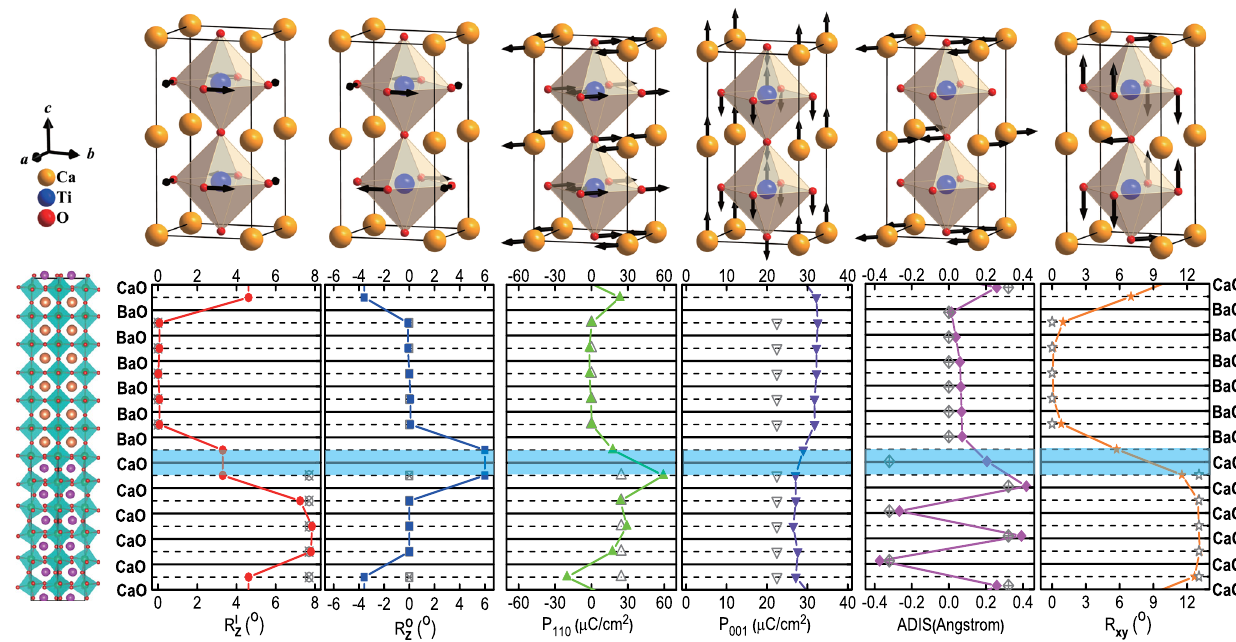
FIG. 2. Computed local properties associated with ferroelectric and nonpolar modes in 6 BTO = 6 CTO superlattice and schematic plots for the atomic displacements of the oxygen octahedron rotation and ferroelectric modes. First-principles calculations of a 6 BTO = 6 CTO superlattice showing layer-by-layer decompositions of in-phase oxygen octahedron rotation around [001] R i , out-of-phase oxygen z octahedron rotation around [001] R o , in-plane polarization P 110 , out-of-plane polarization P 001 , antipolar modes (AFE) represented by z A-site cation displacements (ADIS), and oxygen octahedron rotation around [110] R . The corresponding strained bulk values are also xy denoted by the open symbol in the plot, and in particular, the open strained bulk values in P 001 are predicted by the dielectric slab model [14]. A highly polar BiFeO 3 -like interface phase in CTO is highlighted in blue.